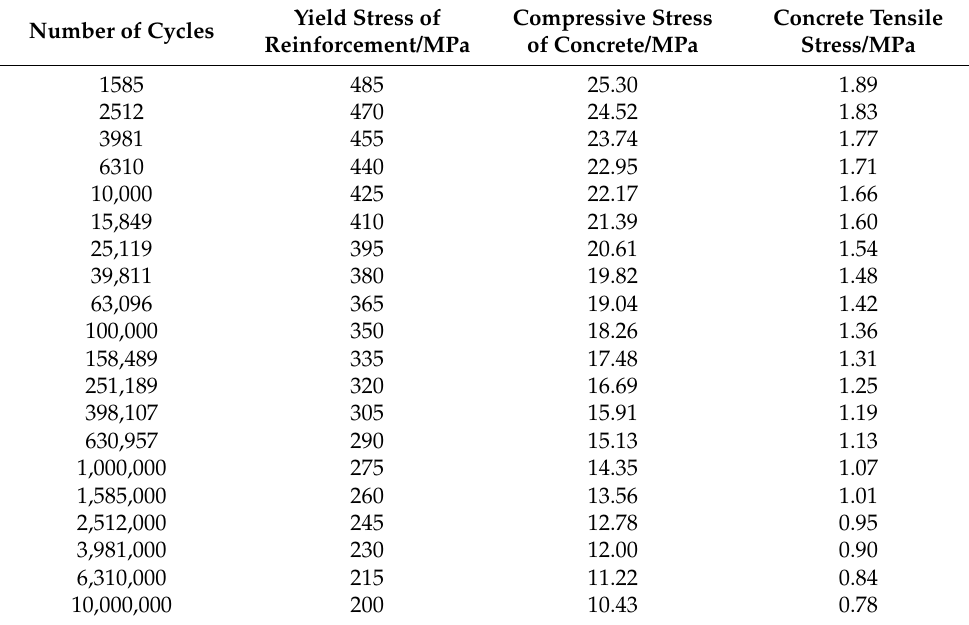
Table 3. The fatigue test values of the reinforcement and concrete. Yield Stress of Compressive Stress Concrete Number of Cycles Reinforcement/MPa of Concrete/MPa